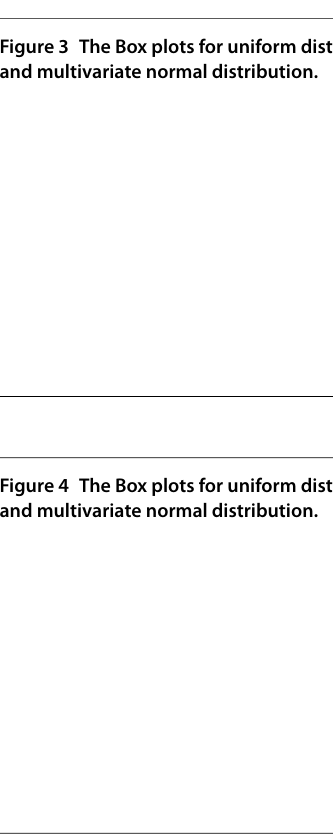
Figure 3 The Box plots for uniform distribution and multivariate normal distribution.